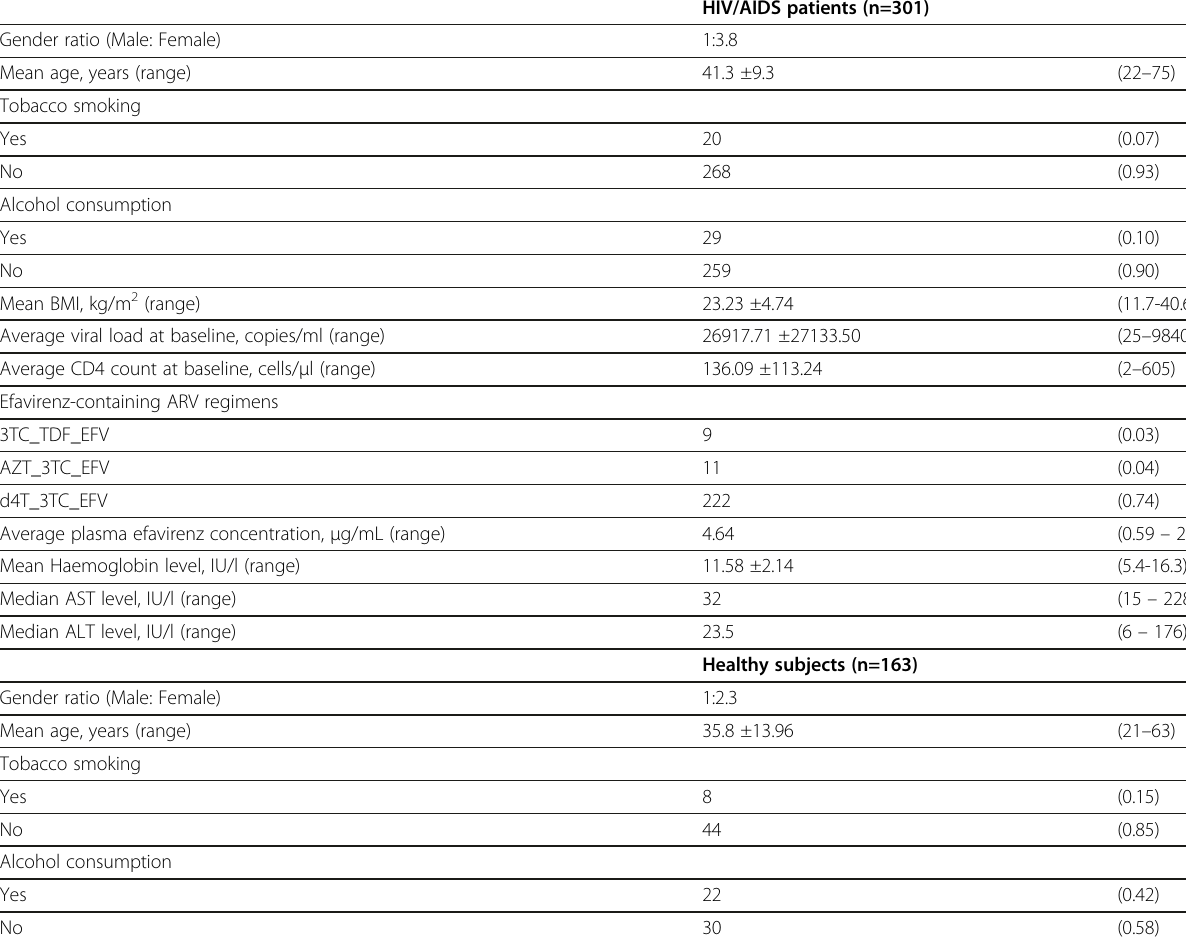
Table 1 Demographic characteristics of the healthy participants and HIV/AIDS patients